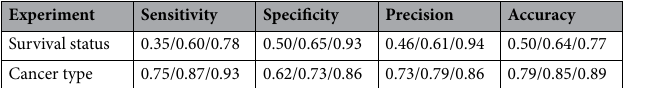
Table 3. Performance of the Greedy Decision Forest